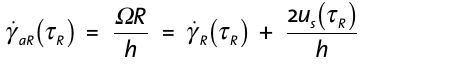
Figure 3: The apparent shear rate as a function of the inverse of the rheometer gap for a 1% w/w non-modified (hydroxypropyl) guar aqueous solution at five imposed shear